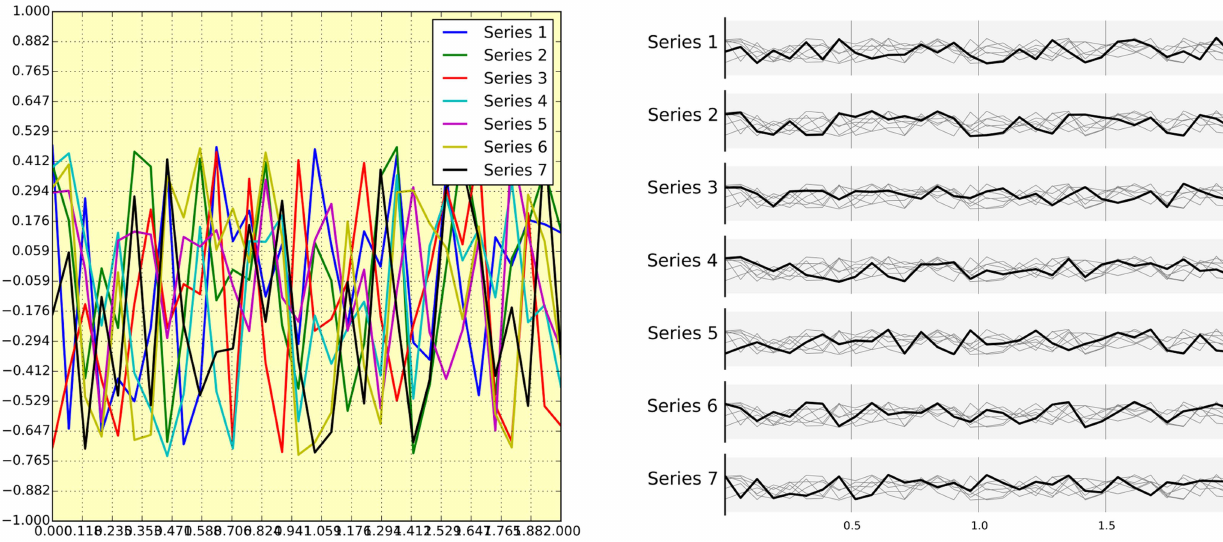
Figure 7. Avoid chartjunk. We have seven series of samples that are equally important, and we would like to show them all in order to visually compare them (exact signal values are supposed to be given elsewhere). The left figure demonstrates what is certainly one of the worst possible designs. All the curves cover each other and the different colors (that have been badly and automatically chosen by the software) do not help to distinguish them. The legend box overlaps part of the graphic, making it impossible to check if there is any interesting information in this area. There are far too many ticks: x labels overlap each other, making them unreadable, and the three-digit precision does not seem to carry any significant information. Finally, the grid does not help because (among other criticisms) it is not aligned with the signal, which can be considered discrete given the small number of sample points. The right figure adopts a radically different layout while using the same area on the sheet of paper. Series have been split into seven plots, each of them showing one series, while other series are drawn very lightly behind the main one. Series labels have been put on the left of each plot, avoiding the use of colors and a legend box. The number of x ticks has been reduced to three, and a thin line indicates these three values for all plots. Finally, y ticks have been completely removed and the height of the gray background boxes indicate the [ 2 1, + 1] range (this should also be indicated in the figure caption if it were to be used in an article).